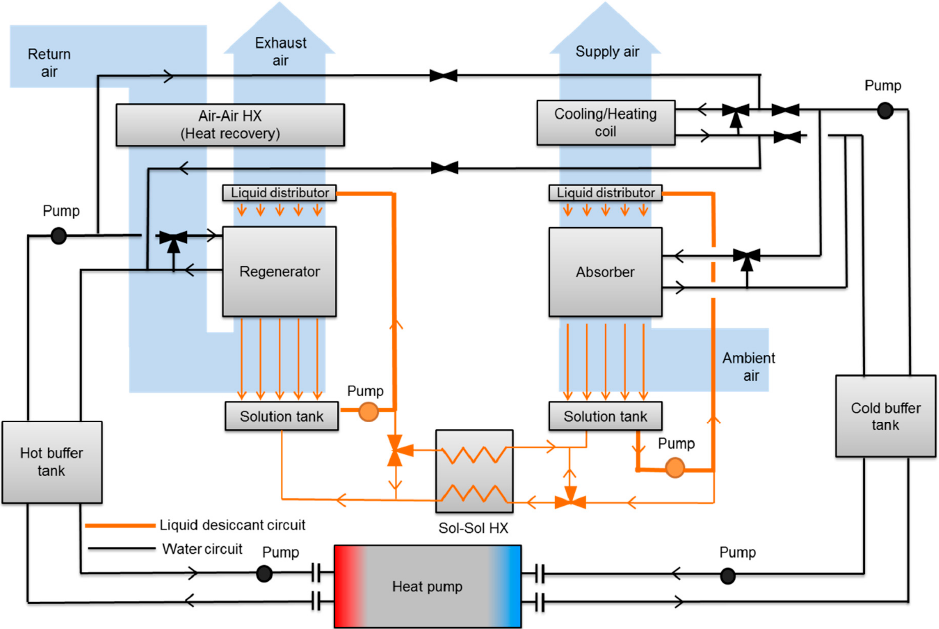
Figure 1. General scheme of the hybrid liquid desiccant system (HLDS) coupled to the vapor compression heat pump (adapted from [6]).